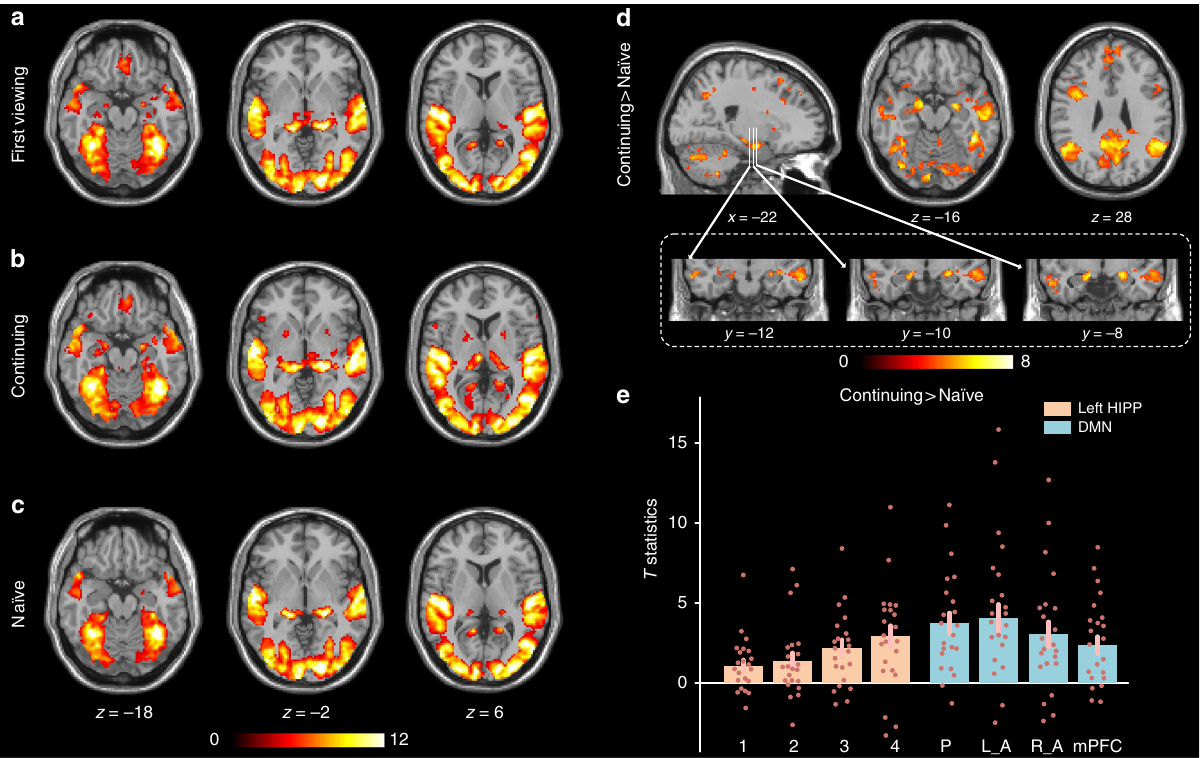
Fig. 1 GLM results of news clip viewing. a Brain regions with statistically signi fi cant activation during fi rst viewing, b continued-viewing, c naïve viewing. d Brain regions with greater activation to the continuing viewing than naïve viewing. e Average T statistics in left hippocampus (1 – 4 represents four hippocampal parcels from posterior to anterior hippocampus; see Methods, Supplementary Figure 14) and DMN (P: precuneus, L_A: left angular gyrus, R_A: right angular gyrus, mPFC: medial prefrontal cortex) across participants. Signi fi cant voxels were identi fi ed using a FWE cluster-corrected threshold p < 0.001, with a voxel height de fi ned with p < 0.001. Error bars signify